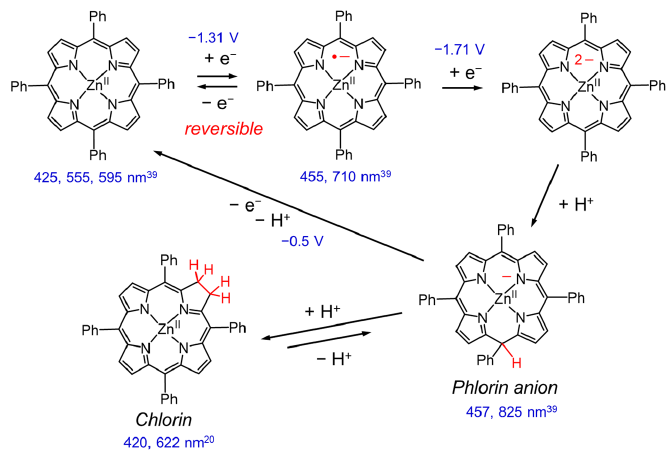
Figure 5. Electrochemical reduction of ZnTPP [39] and formation of chlorin [41,42]. The redox potentials are denoted with respect to an aqueous SCE [39]. The numbers in nm are peak wavelengths of UV–vis absorption spectra.